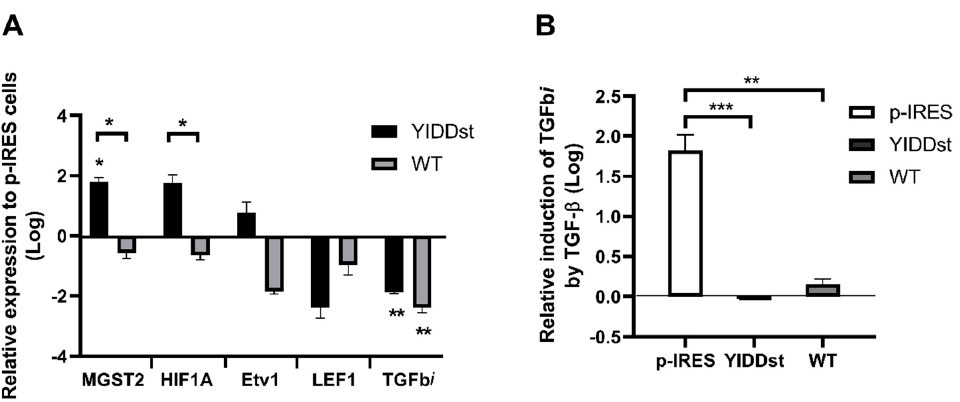
Figure 6. Validation of differentially expressed genes by RT-qPCR. ( A ) The relative expressions of five genes in the YIDDst- or WT-transfected cells (black and grey bar, rspectively) to the mock-control cells are shown. * p < 0.01; ** p < 0.001, multiple t -test; the n-zig-zag line shows significant differences between the expressions in the YIDDst- and WT-cells. ( B ) The relative induction of transforming growth factor beta-induced ( TGFbi ) after the addition of TGF- β in the control-, YIDDst-, and WT-cells. ** p < 0.01, *** p < 0.001, t -test.